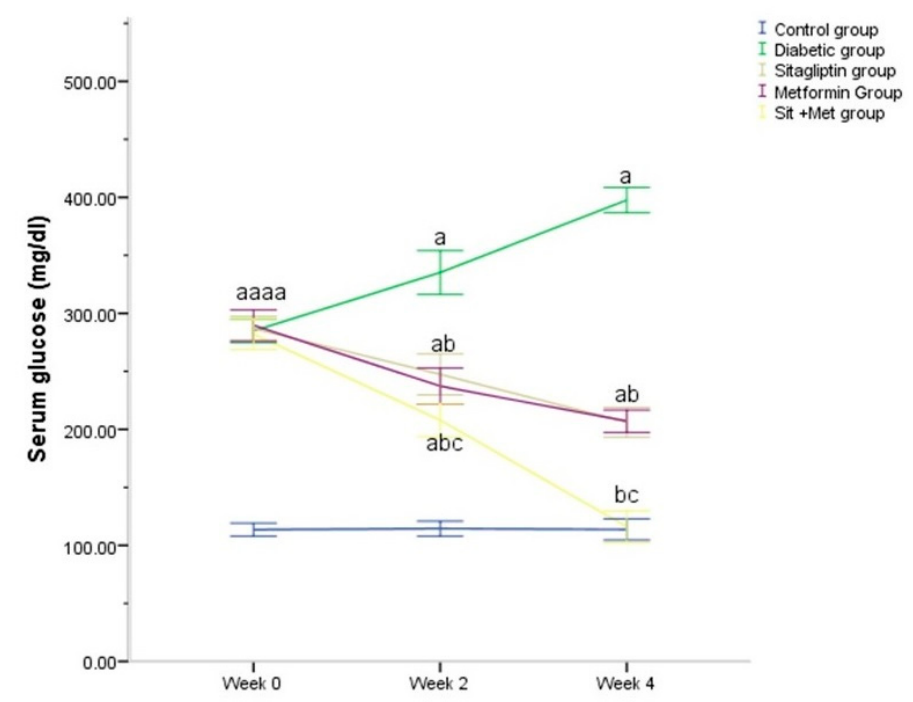
Figure 1. Changes in serum glucose (mg / dL) during the treatment period in the di ff erent studied groups. The values were expressed as mean ± SD (n = 10). a : significantly di ff erent, compared to the control group. b : significantly di ff erent, compared to the untreated diabetic group. c : significantly di ff erent, compared to the sitagliptin and metformin-treated groups, using post hoc ANOVA (LSD), p < 0.05.